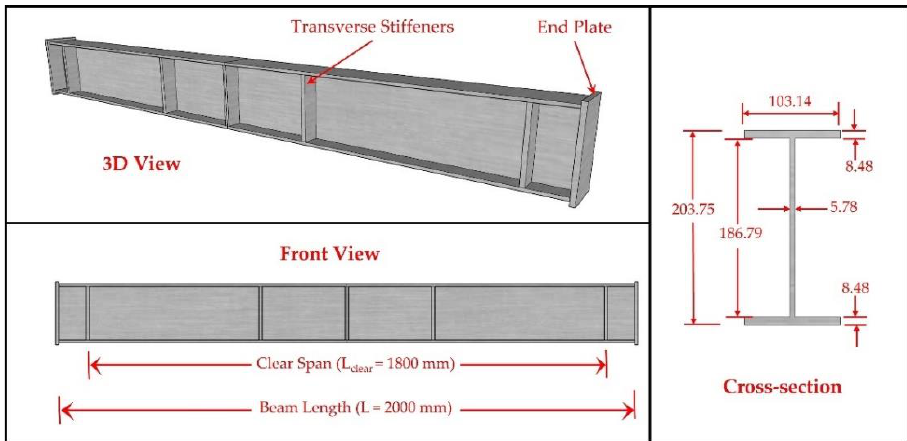
Figure 1. Schematic views and dimensions of the control beam (dimensions are in mm).